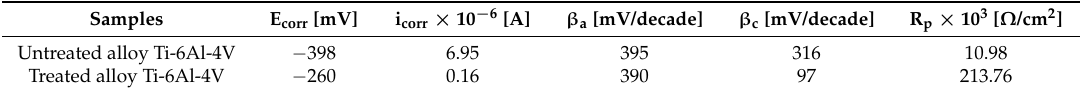
Table 2. Calculated corrosion test results of untreated alloy Ti-6Al-4V and treated by MAO process specimens. Both examined in 3.5 wt % NaCl.